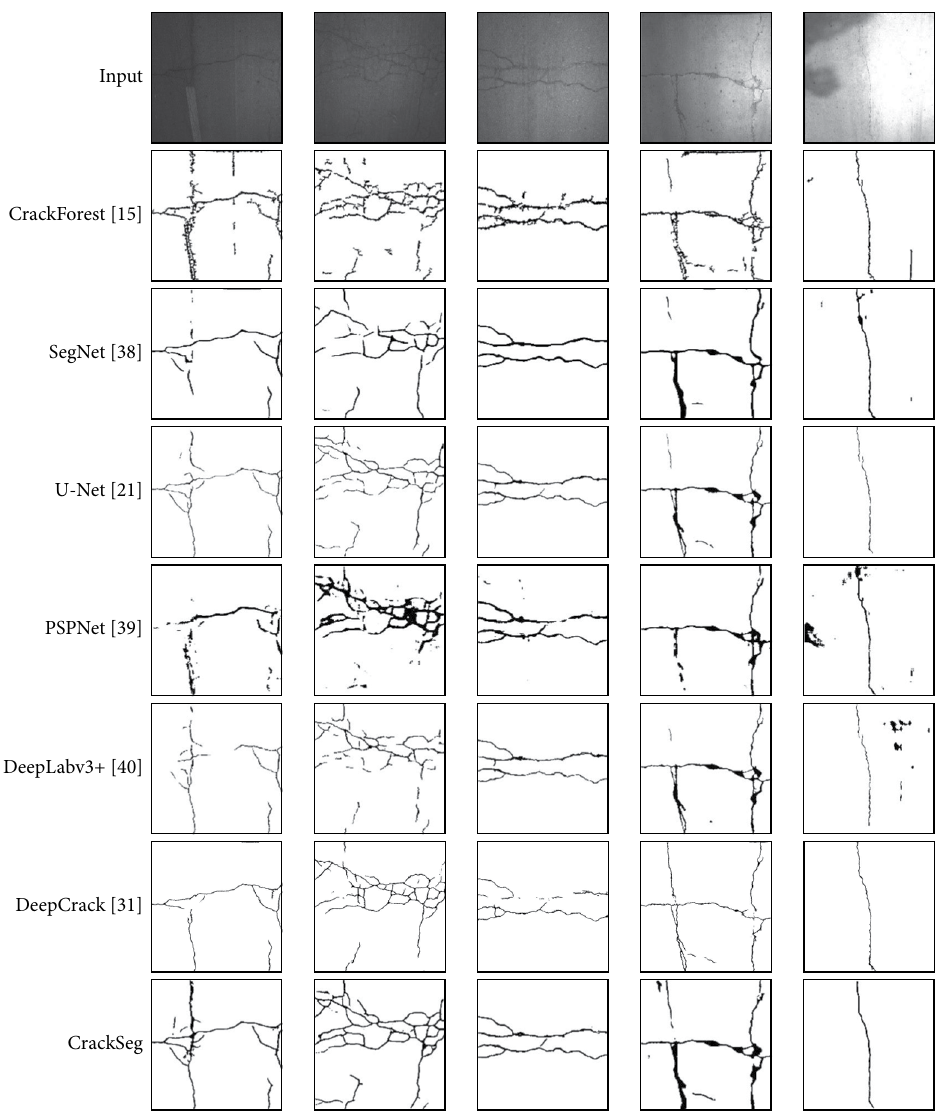
Figure 5: Comparison of results obtained by different methods on five sample images selected from our